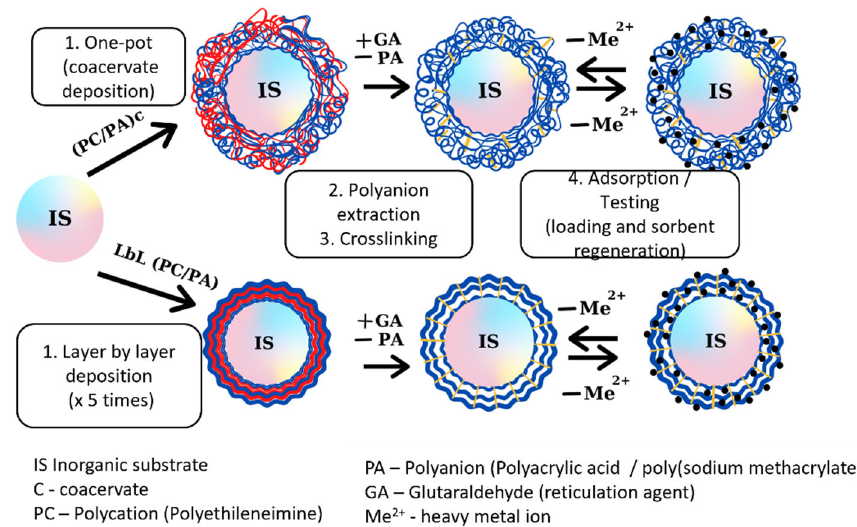
Figure 1. Inorganic/organic composite synthesis routes (adapted with permission after [2]; copyright 2022, Elsevier).